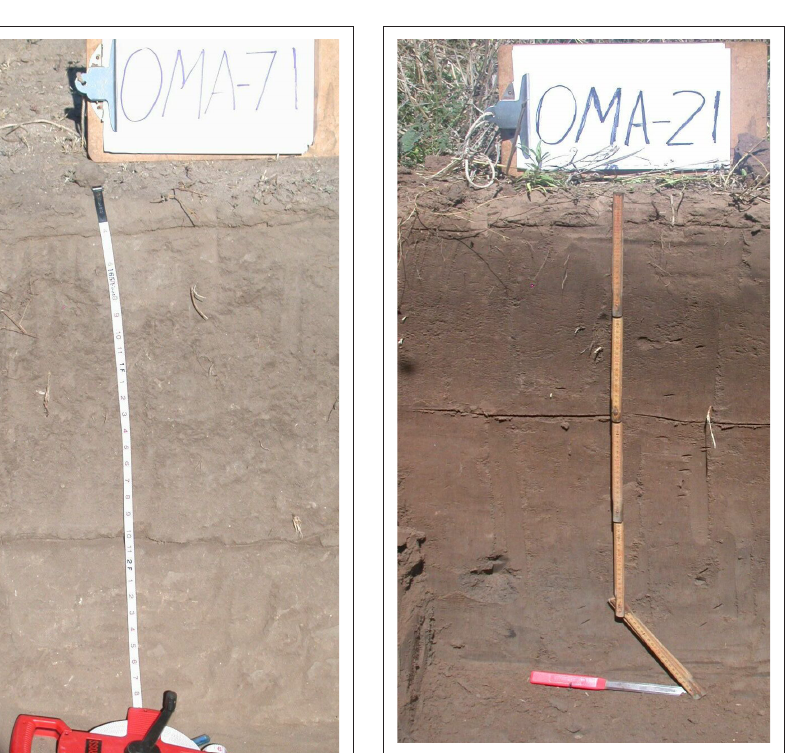
FIGURE A1.3: An arenic Fluvisol consists of an ochric A-horizon and a dark brown Bw1-horizon over weakly wet or gleyed clay-rich material (Bw2-horizon).